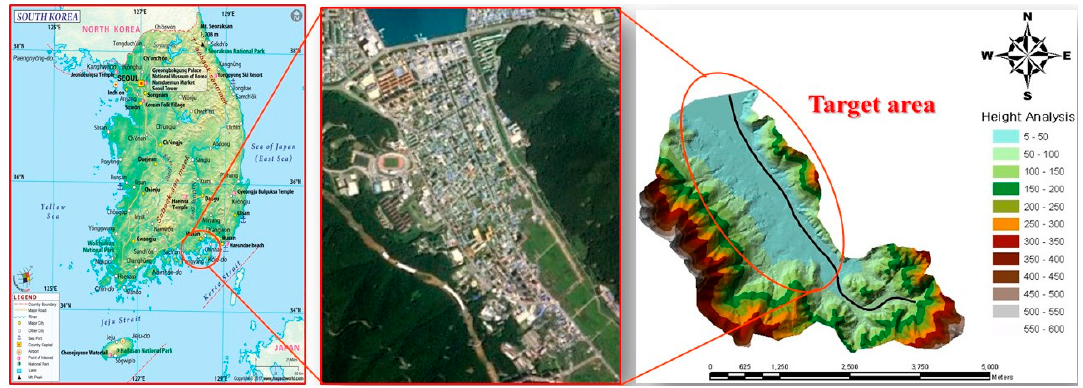
Figure 3. Satellite image of a coastal urban area in the Gohyun river basin and target area (unit: meter).